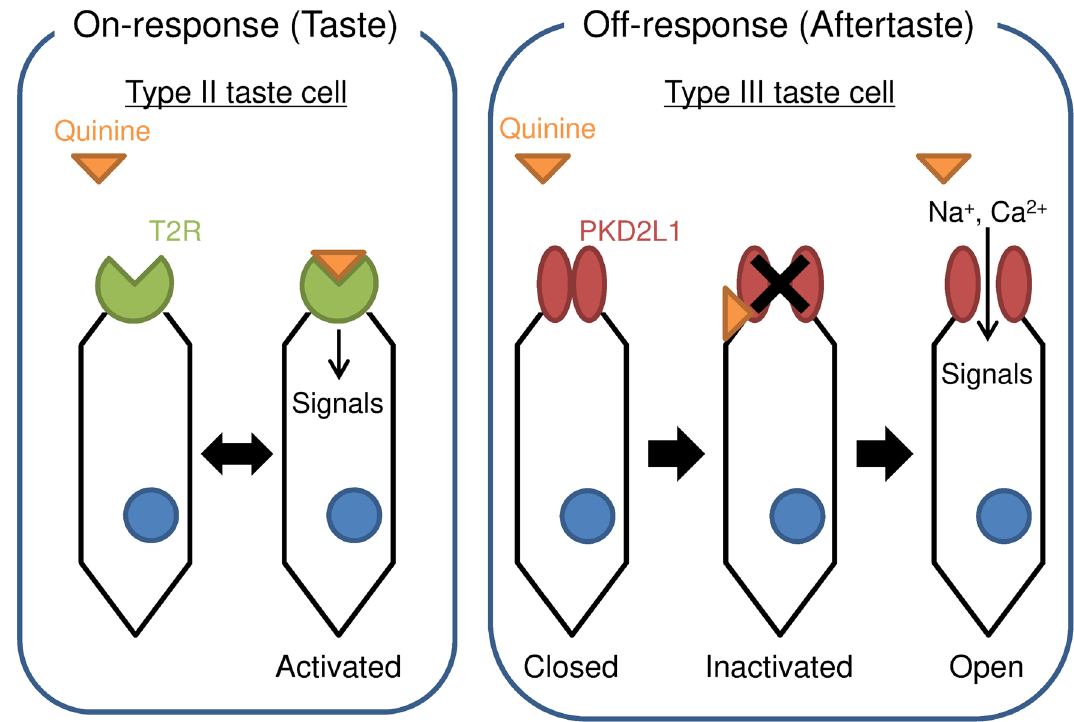
Figure 7. Proposed models of on- and off-response triggered by quinine. In Type II taste cells, quinine binds with the taste receptor 2 (T2R), a G-protein-coupled receptor, which triggers intracellular signals for bitter taste perception. On the other hand, quinine inactivated the PKD2L1 channel in Type III taste cells., The off-response of the PKD2L1 channel after the removal of quinine causes depolarization and elevation of [Ca 2+ ] i , leading to a bitter